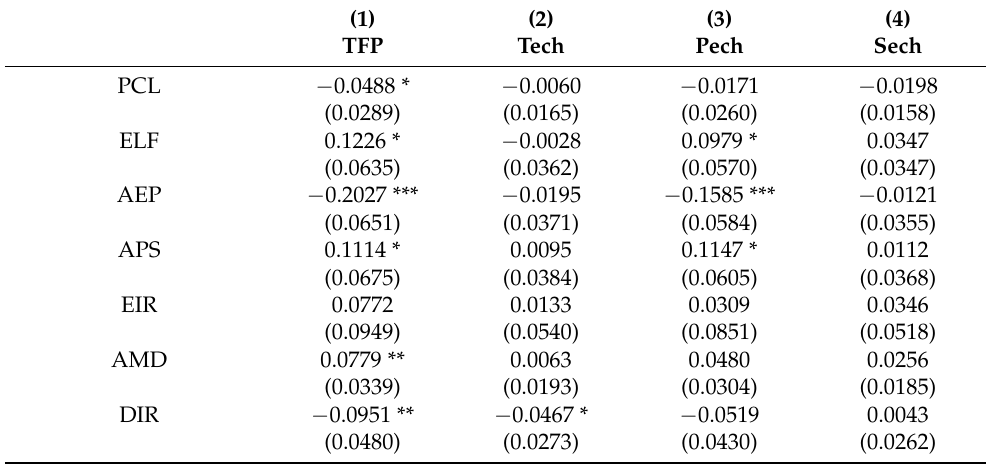
Table 4. Factors Affecting Rice Production Efficiency and Its Decomposition